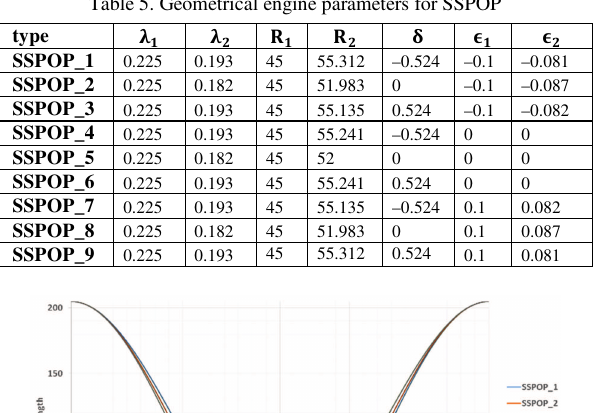
Table 5. Geometrical engine parameters for SSPOP